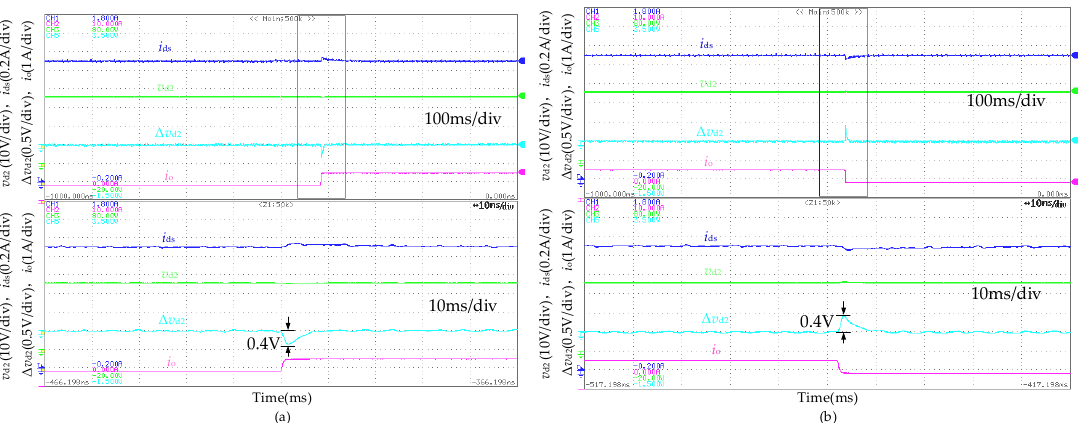
Figure 10 . The experimental results of i ds , v d2 , Δ v d2 and i o with LADRC method, ω n = 1521rad/s and r v = 0 Ω: ( a ) sudden load increase; ( b ) sudden load decrease. r v = 0 Ω : ( a ) sudden load increase; ( b ) sudden load decrease.